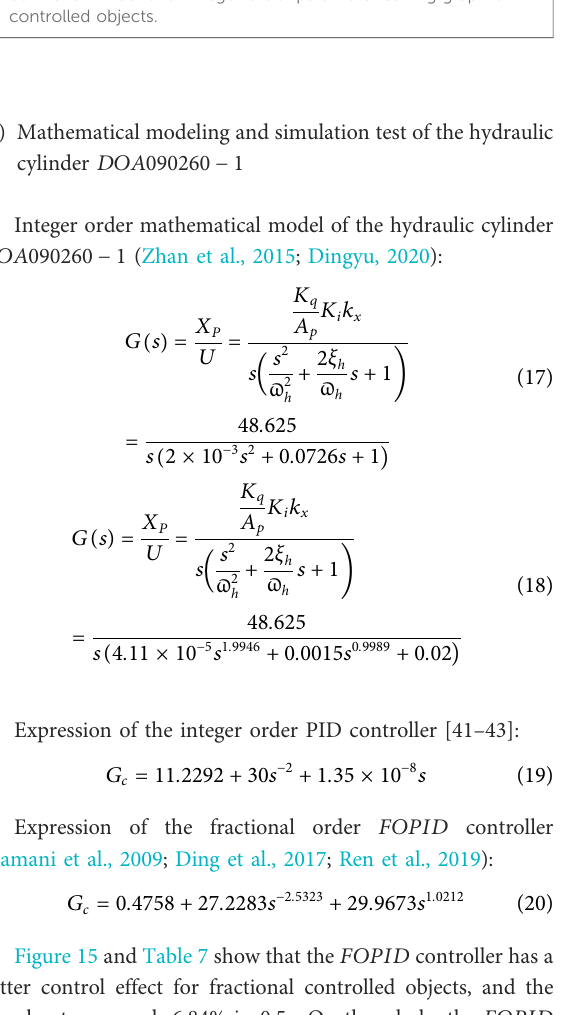
and takes another 16 min in total to complete the support work of a section. Cost function vs. iterations is plotted for the mathematical modeling and simulation tests of the hydraulic ( Continued ) cylinder, as shown in Figure 16.